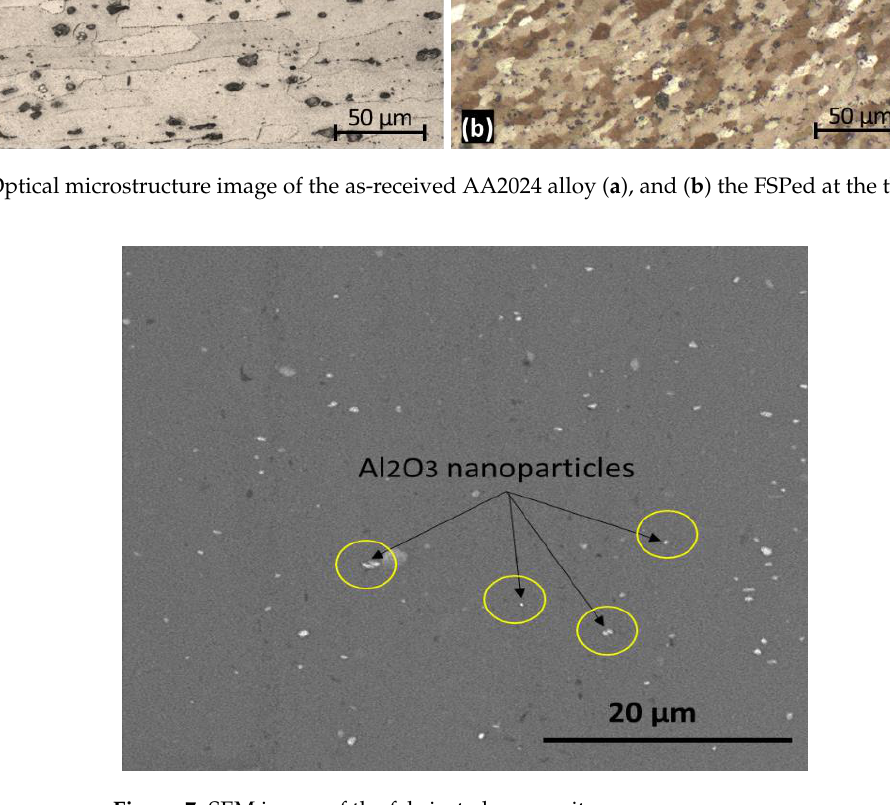
Figure 7. SEM image of the fabricated